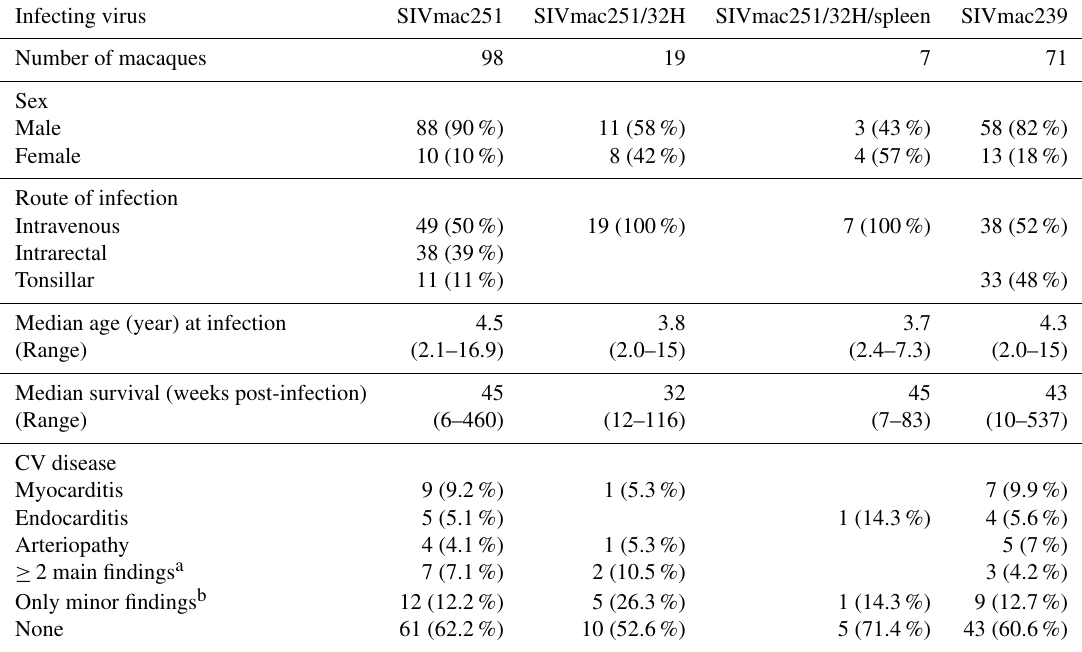
Table 1. Description of the cohort and incidence of cardiovascular (CV) disease in the SIV-infected rhesus macaques ( Macaca mulatta ) of Indian